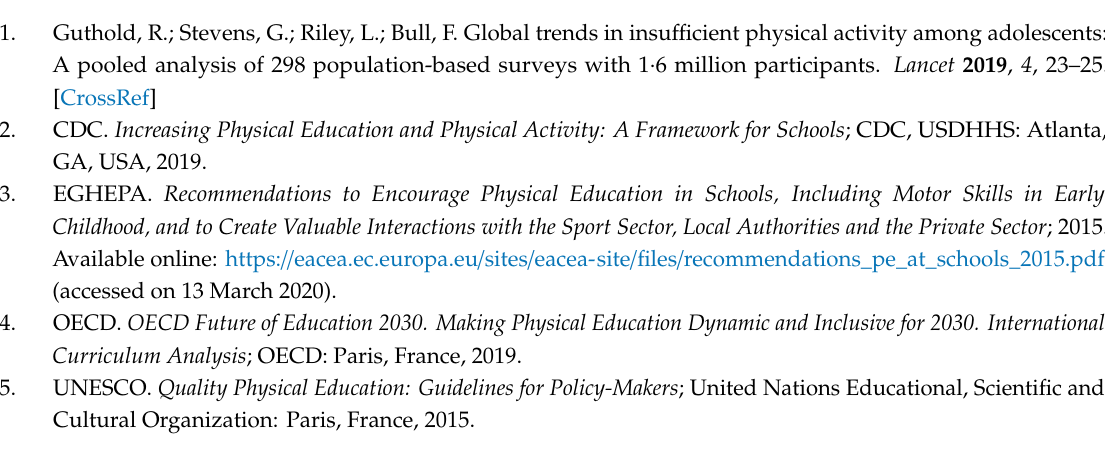
Table S1: Survey year and sample size for countries that participated in the Global School-Based Health Survey, 2010–2015., Table S2: Participation in physical education classes by